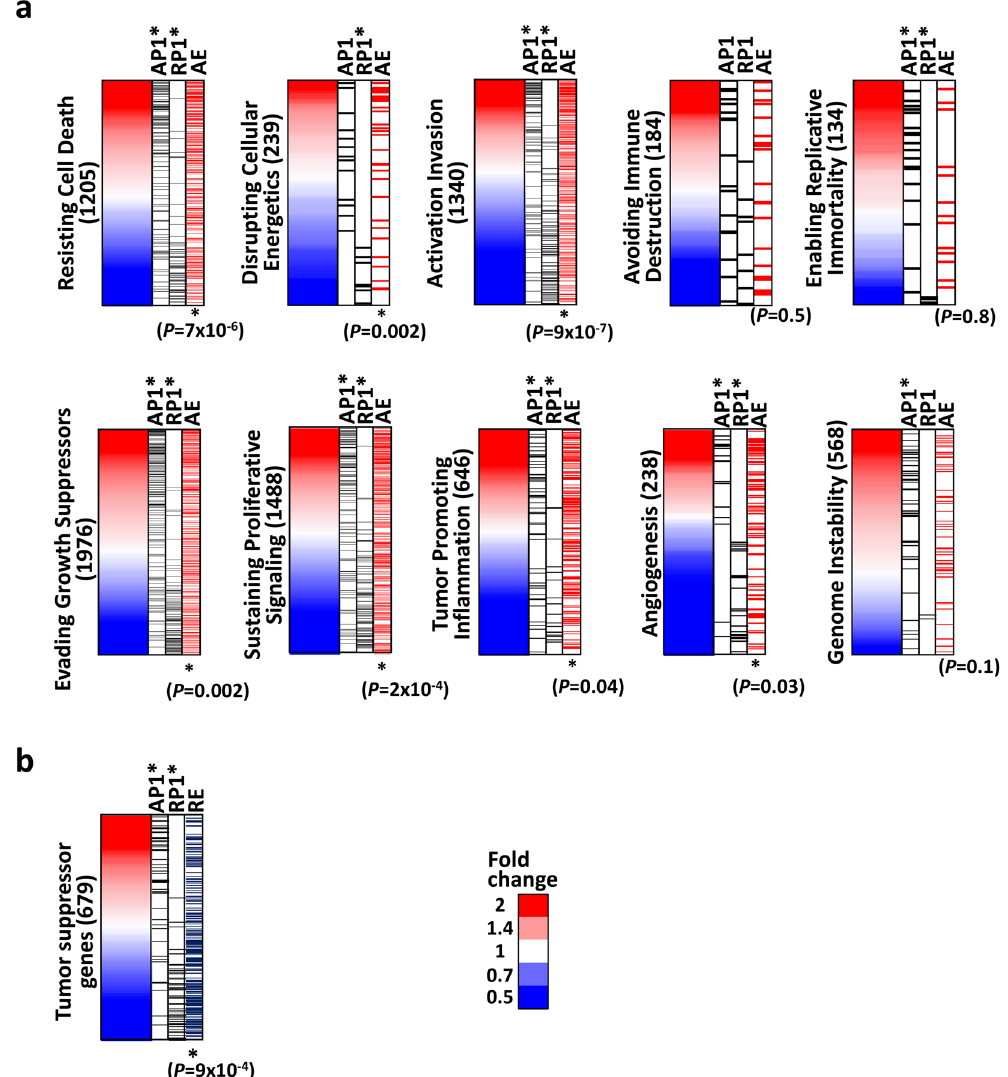
Figure 4. Epigenetic regulation of cancer hallmark genes and tumour suppressor genes. ( a ) Cancer hallmark genes. Genes were sorted according to fold expression changes. Black bars show association with activated promoters and repressed promoters, respectively. Red bars show association with activated enhancers (AE1). P -value was calculated by Kolmogorov-Smirnov test. Enhancer activation was significantly associated with upregulation of cancer hallmark genes, e.g., “Resisting cell death”, “Disrupting cellular energetics”, “Activation invasion”, “Evading growth suppressors”, “Sustaining proliferative signalling”, and “Tumour promoting inflammation”. ( b ) Black bars show association with activated promoters and repressed promoters, respectively. Blue bars show association with repressed enhancers (RE1). Enhancer repression was significantly associated with repression of tumour suppressor